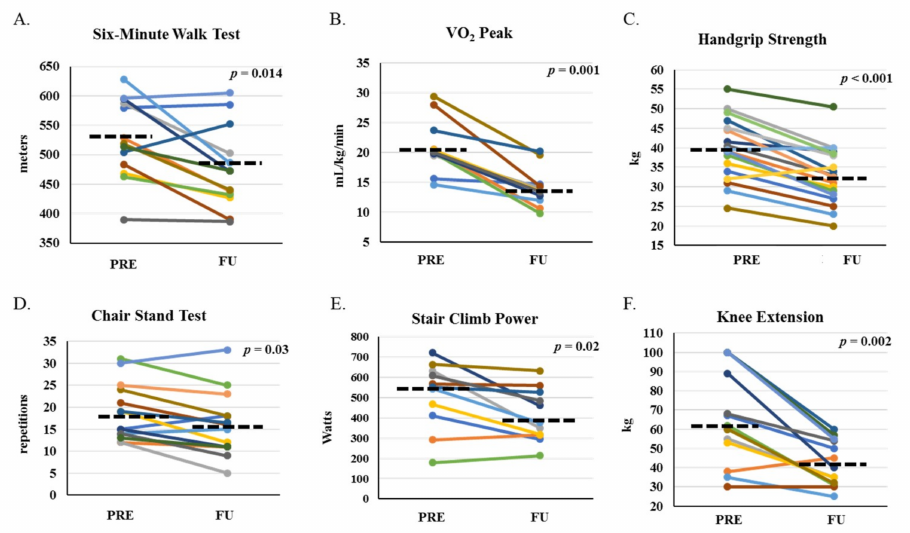
Figure 2. Physical function before and one-month after HCT. Physical function performance at PRE and FU for six-minute walk test ( A ), aerobic capacity (VO 2 peak) ( B ), average handgrip of two individual hands ( C ), chair stand test ( D ), stair climb power ( E ), and knee extension one-repetition maximum as a representative image of lower body strength ( F ). p -values indicate paired-sample comparison between PRE and FU. Dashed lined represent median at PRE and FU.